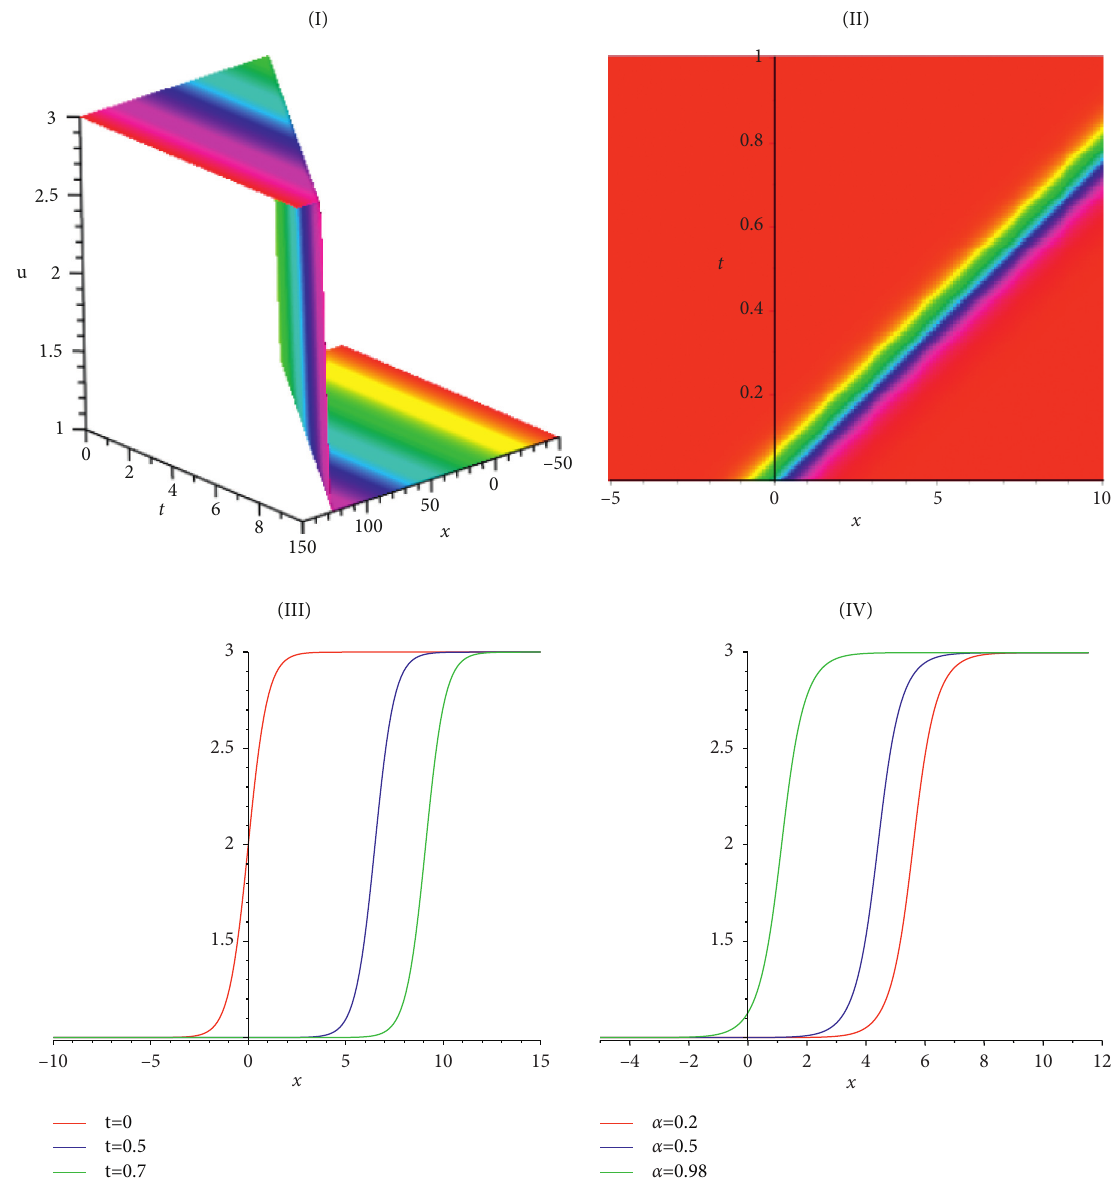
Figure 7: Evolution of the periodic solution (30) with data r � , k